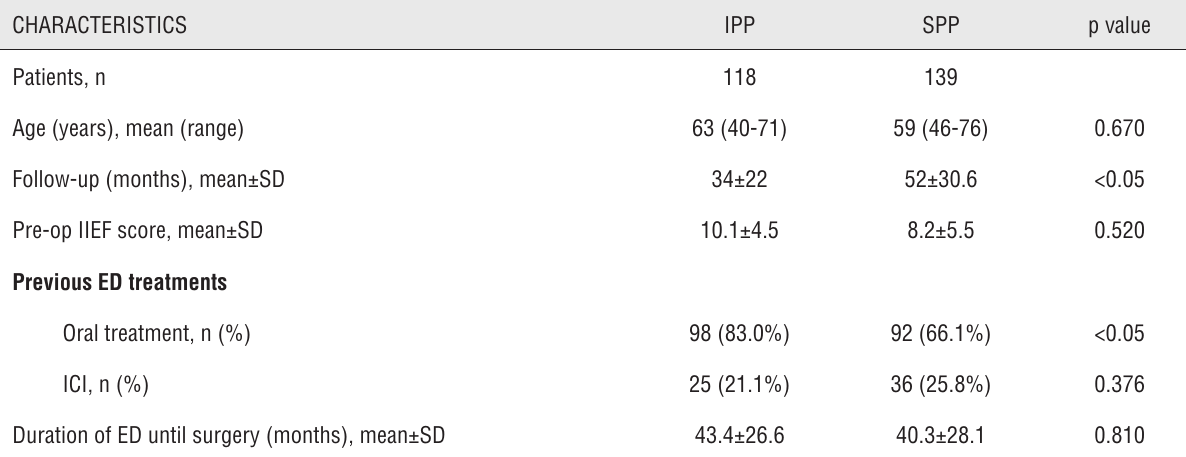
Table 1 - Patients’ characteristics.